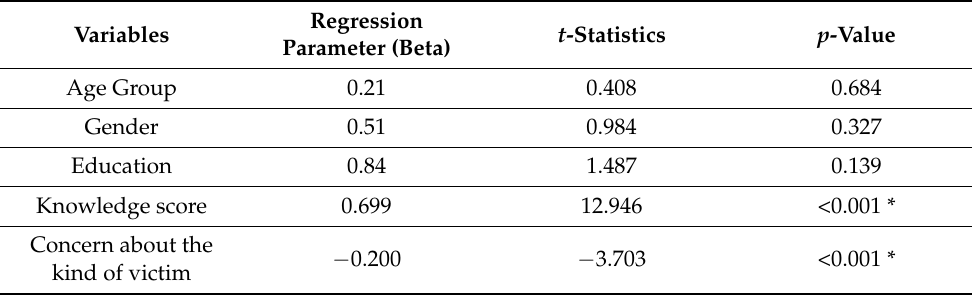
Table 3. Linear Regression Analysis for predictors of positive attitude in using AED. Regression t Variables Parameter (Beta)